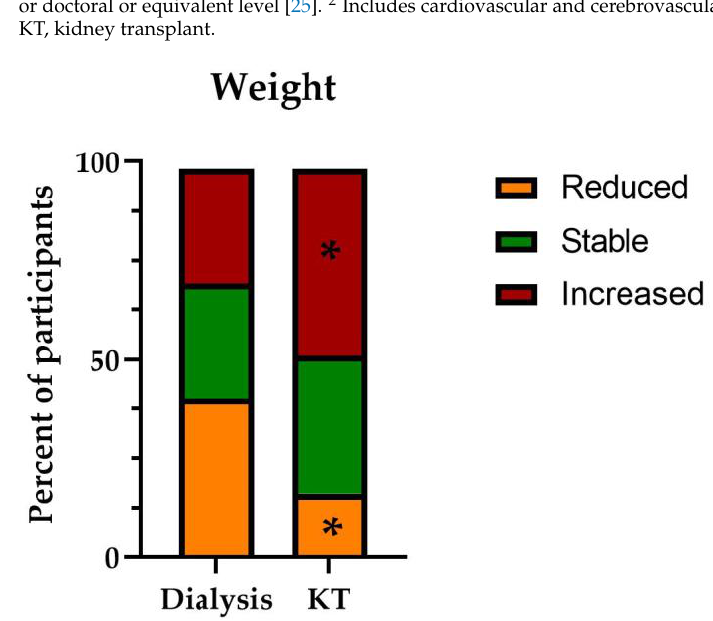
Figure 1. Weight change since the start of dialysis or KT. * p < 0.05. In both groups, the majority of participants lived in Northern Italy, had an intermediate level of education (upper secondary or post-secondary non-tertiary education [25]), and were workers. The proportion of participants with comorbidities was similar between the groups, with numerically higher figures for hypertension and dyslipidemia in the KT group. Median time since KT was 6.0 (3.0; 13.0) years. Approximately half (52%) of KT recipients were on steroid therapy. Table 1. Participant characteristics. Variable